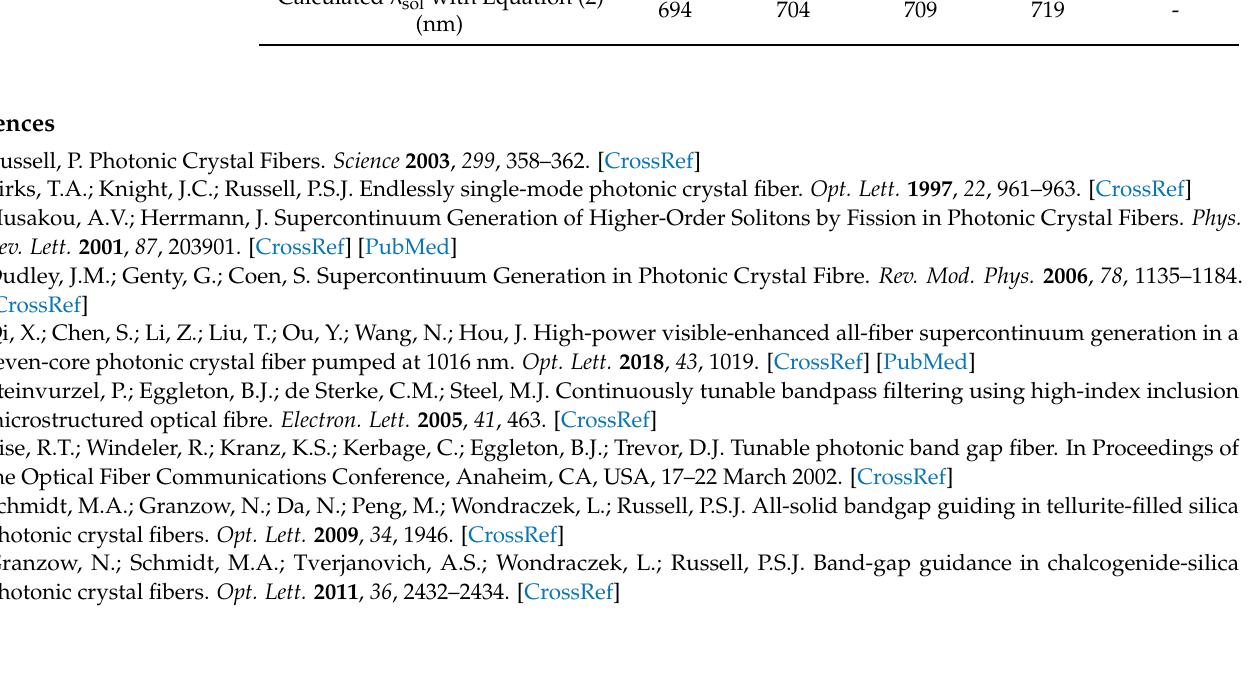
Calculated λ sol with Equation (2)